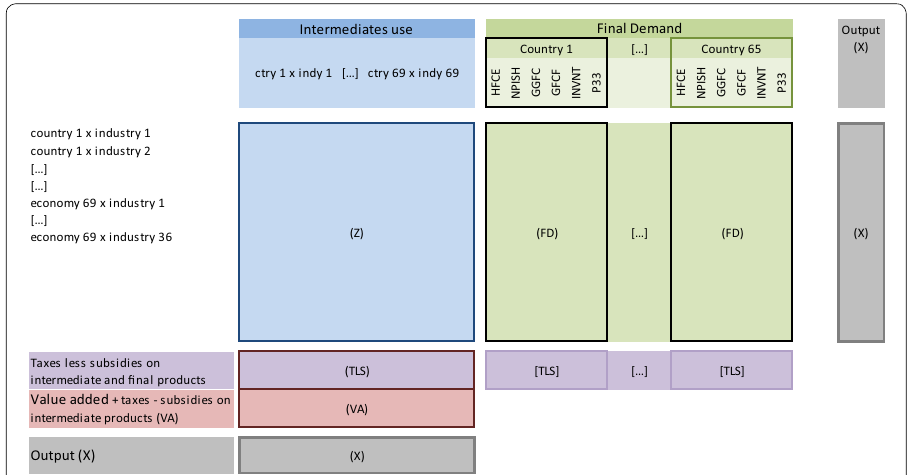
Fig. 1 Structure of ICIO Tables, 2018 edition. The ICIO table includes a 2484 square intermediate transaction matrix ( Z ); a 65 2848 taxes less subsidies on intermediate and final products matrix (TLS); a 1 × of value added—including net taxes—(VA), a 1 2484 vector of total output ( X ); a 2484*414 final demand × matrix—6 final demand categories for each country (source: OCDE